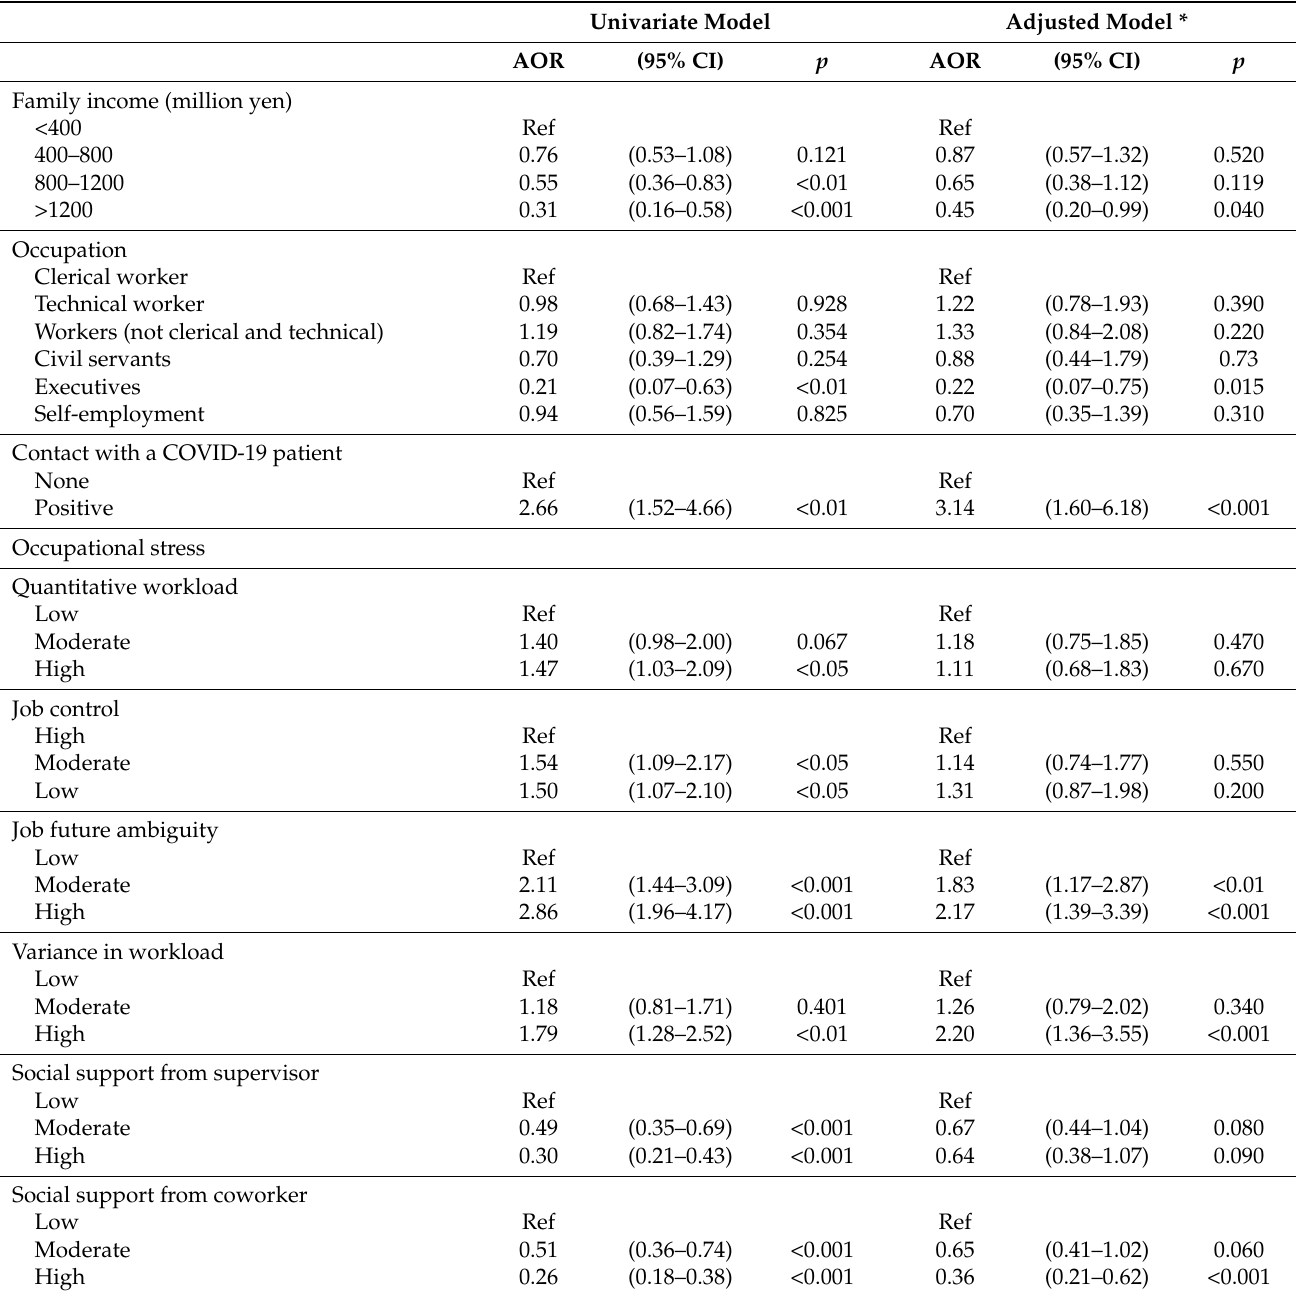
Table 3. Multiple logistic regression analysis of risk factors related to the DEP group, compared with the non-DEP